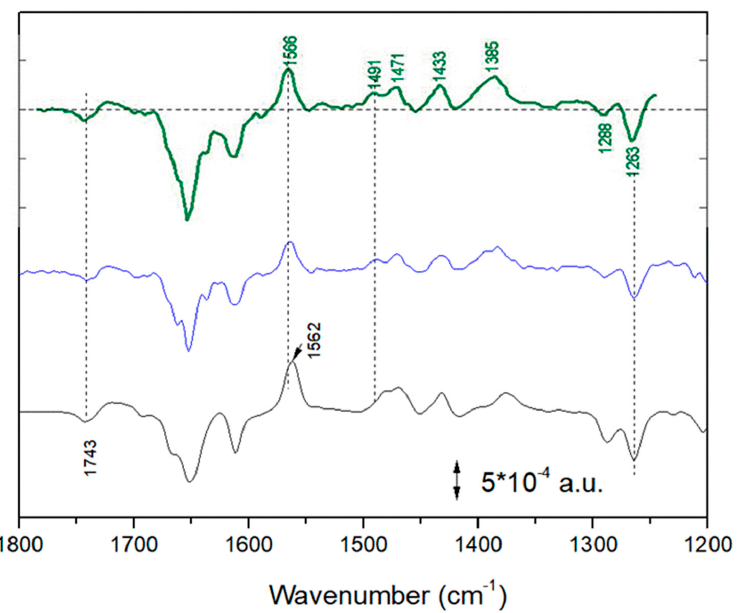
Figure 4. FTIR difference spectra reflecting reduction of the quinone pool with formation of the new species characterized by a band at ~1565 cm − 1 . From top to bottom: green spectrum, taken from [7], obtained after a Multivariate Curve Resolution treatment of time-resolved FTIR difference data on chromatophores. Blue spectrum, recorded between 1, 3 and 3 s after strong illumination (last bottom trace of time-resolved FTIR spectra shown in Figure 3). Black spectrum: spectrum recorded on chromatophores between 1 and 3 s after strong illumination in D 2 O. Peak position should be considered to have a ±1 cm − 1 uncertainty. Green spectrum was adapted with permission from Ref. [7],Copyright 2009 American Chemical Society.